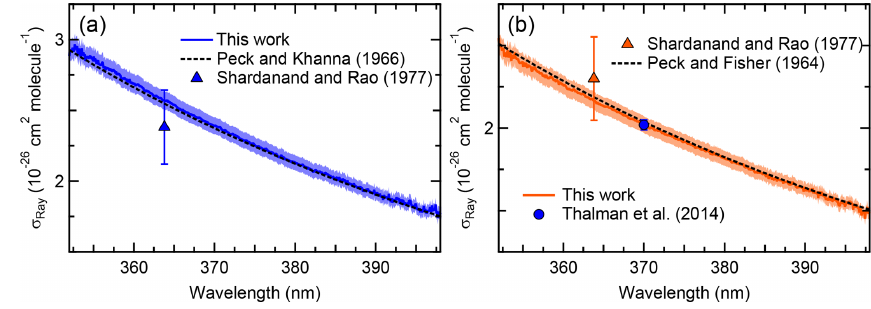
Figure 3. Cross sections of pure gases: (a) N 2 (99.998%, in blue), and (b) Ar (99.998%, orange). Table 2. Summary of observed and literature scattering cross sections at 363.8 and 370.0nm. Gas λ σ Ray σ Ray σ Ray σ Ray (purity) (nm)